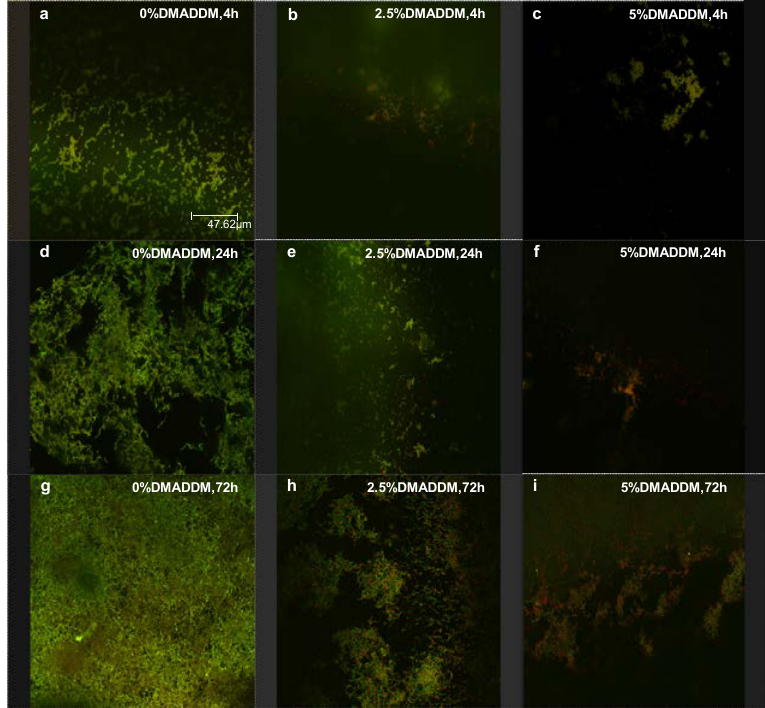
Each group name is indicated in the image. Live bacteria were stained green, and dead bacteria were stained red. Live and dead bacteria in close proximity to each other yielded yellow and orange colors. Incorporation of DMADDM into the adhesive provided strong antibacterial effects. ( a ) 0% DMADDM group, 4 h; ( b )2.5% DMADDM group, 4 h; ( c ) 5%DMADDM group, 4 h; ( d ) 0% DMADDM group, 24h; ( e ) 2.5% DMADDM group, 24h ; ( f ) 5% DMADDM group, 24 h; ( g ) 0% DMADDM group, 72 h; ( h ) 2.5%DMADDM group, 72 h; ( i ) 5% DMADDM group, 72